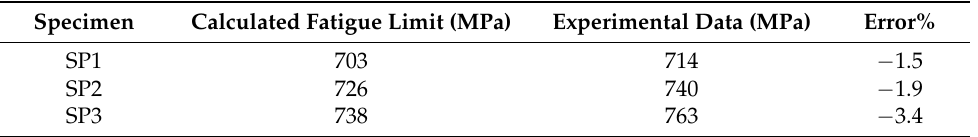
Figure 16. Three-dimensional morphology of specimens before and after shot peening: ( a ) NP specimen; ( b ) SP1 specimen; ( c ) SP2 specimen; ( d ) SP3 specimen.